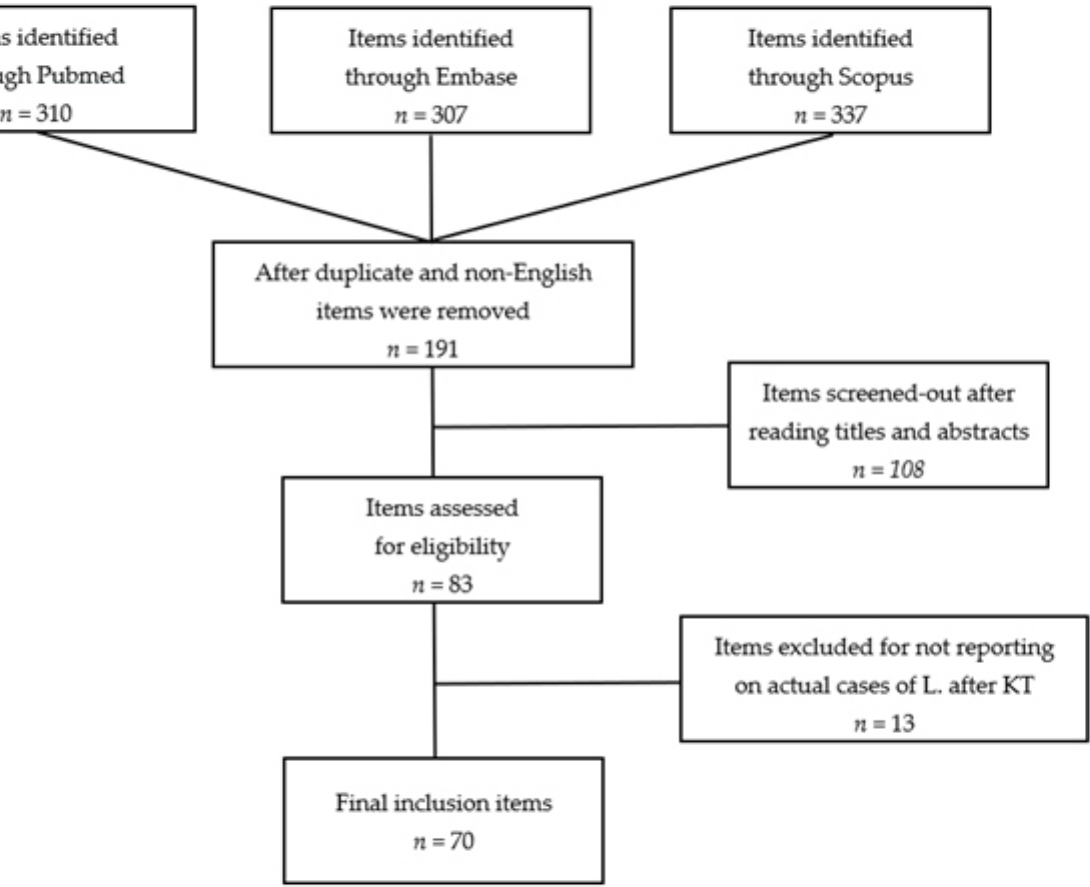
Figure 1. Flow diagram of the systematic review (L., Leishmaniasis; KT, kidney